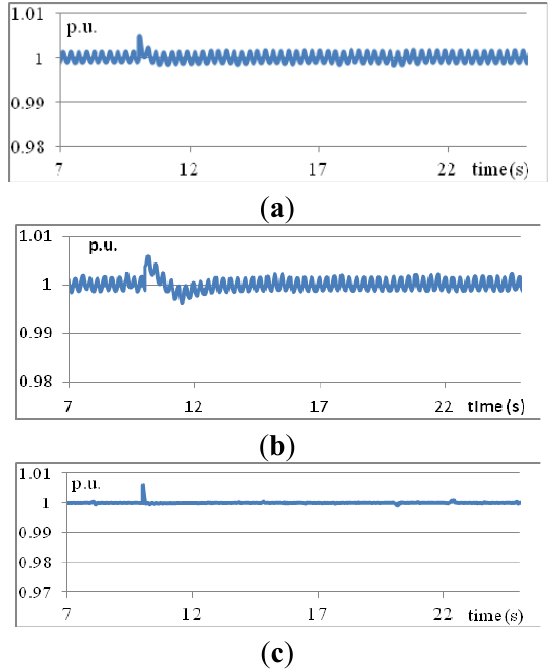
Figure 15. Voltages at bus 3 obtained using three methods: ( a ) traditional PID; ( b ) T1 fuzzy rules; ( c ) IT2 fuzzy rules (Scenario 4).